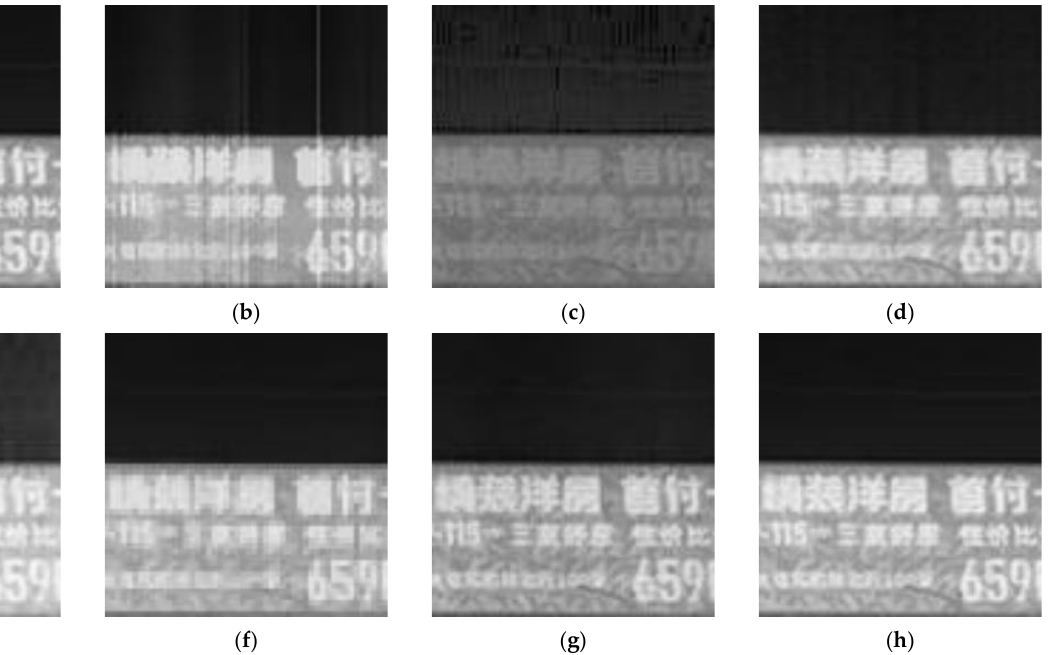
Figure 18. Correction results of Window 1. ( a ) Ideal result; ( b ) BFTH algorithm correction result; ( c )